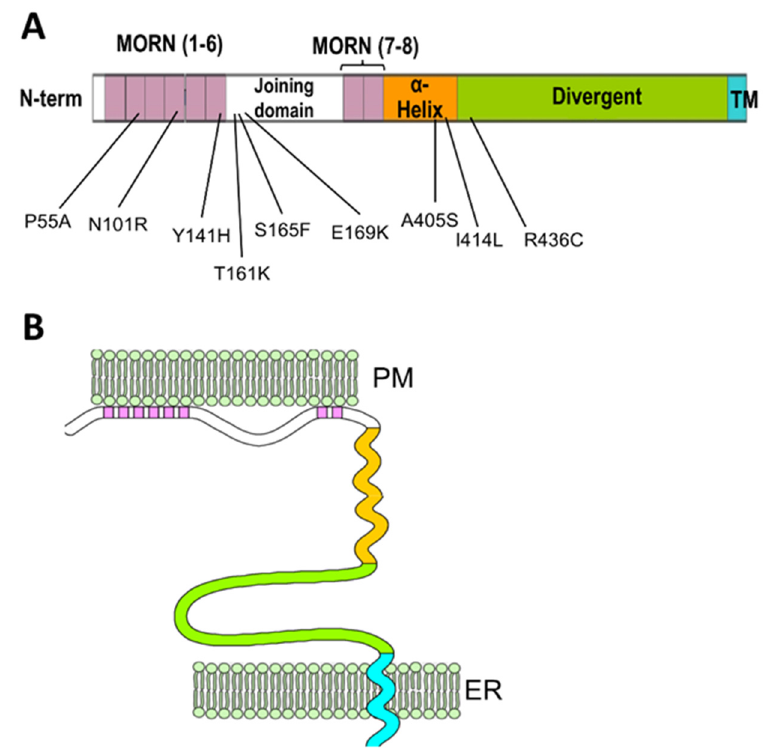
Figure 2. Schematic representation of junctophilin’s domain structure and its arrangement in the ER-PM junction. ( A ) Linear map showing the first (I through IV) and second (VII to VIII) set of MORN domains (in pink) separated by the joining domain (white). The α -helical domain (orange) follows MORN VIII and is separated from the transmembrane (TM, in cyan) by the long divergent domain (green). The numbers underneath the map indicate mutations associated with human cardiomyopathies identified in JPH2 and their relative positions. ( B ) Schematic representation of junctophilin’s organization in the ER-PM junctions (adapted from Garbino et al. [28] ). The MORN motifs associated with the internal leaflet of the plasma membrane and the C-terminal transmembrane domain embedded in the endo/sarcoplasmic reticulum membrane allow junctophilins to bridge the two membrane systems together. Different domains are color-coded as indicated in ( A ).